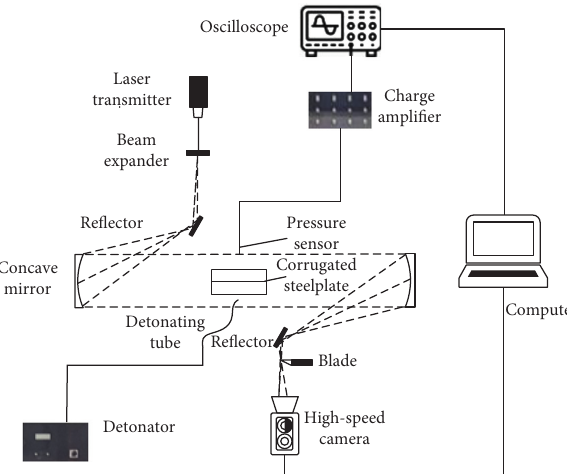
Figure 1: Schematic diagram of the comprehensive experimental test